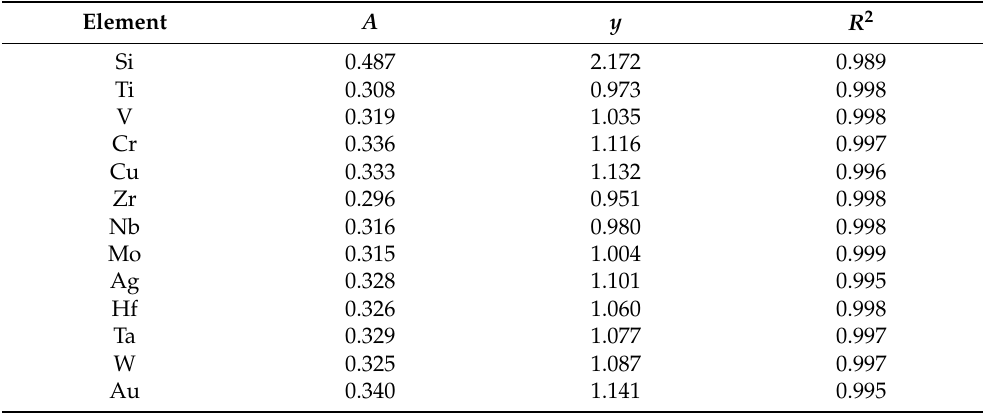
Figure 7. Polar distribution of the differential sputtering yield for metallic elements ( a ) and light elements ( b ). Normalized distributions for the two collections are given in ( c , d ). Graphs for both collections have identical scales; in the case of light elements, the inset also shows excessively high values at low sputtering angles. Table 3. Fitting parameters for cosine approximation of the differential sputtering yield curves; the coefficient of determination R 2 is also